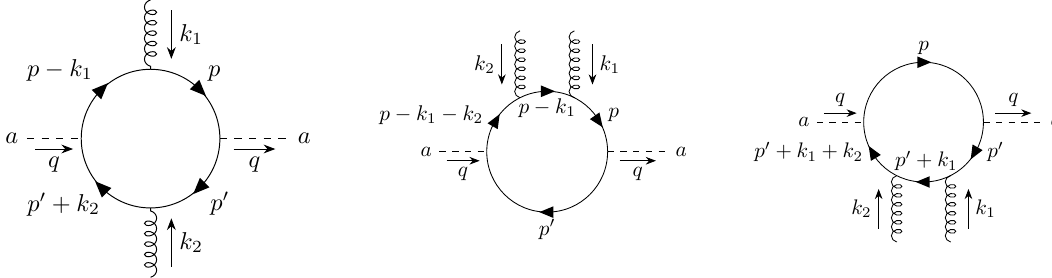
Figure 11 . Visualization of the (cid:12)rst step in the two-loop calculation where we compute the heavy quark loop contribution to the e(cid:11)ective vertices between a and gluons [84]. Here p 0 is given by p 0 = p q (cid:0)